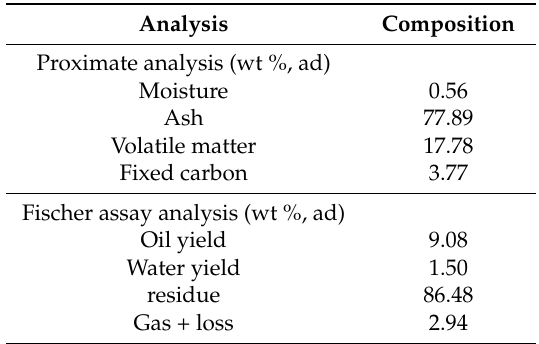
Table 1. Proximate and Fischer assay analyses of the Xinjiang oil